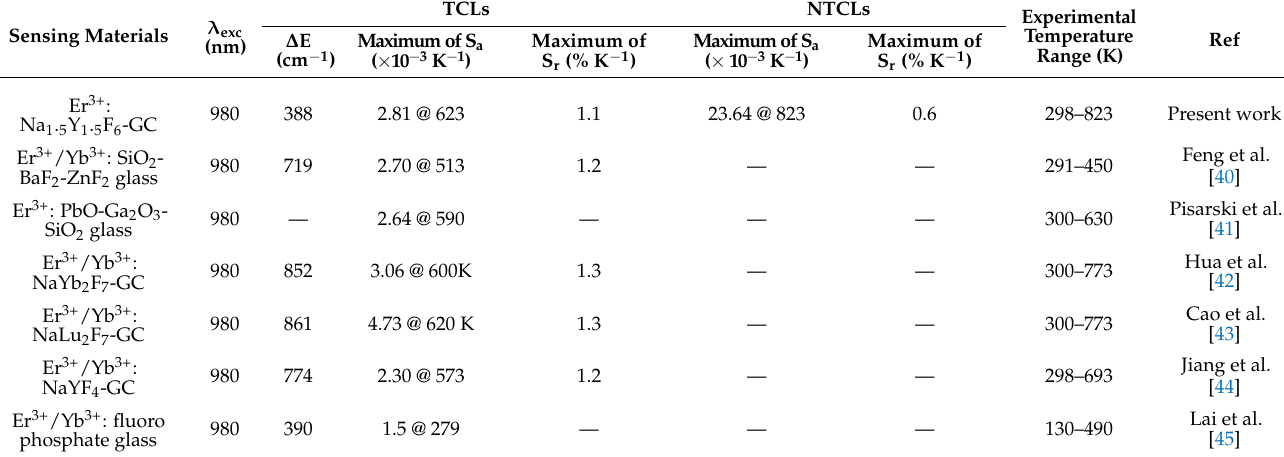
Table 2. Values of the maximum absolute sensitivity, Sa , and relative sensitivity, Sr , at starting temperature, energy spacing ( ∆ E), experimental temperature ranges of different Er 3+ and Er 3+ /Yb 3+ co-doped materials using the fluorescence intensity ratio (FIR) method based on the green emissions of the Er 3+